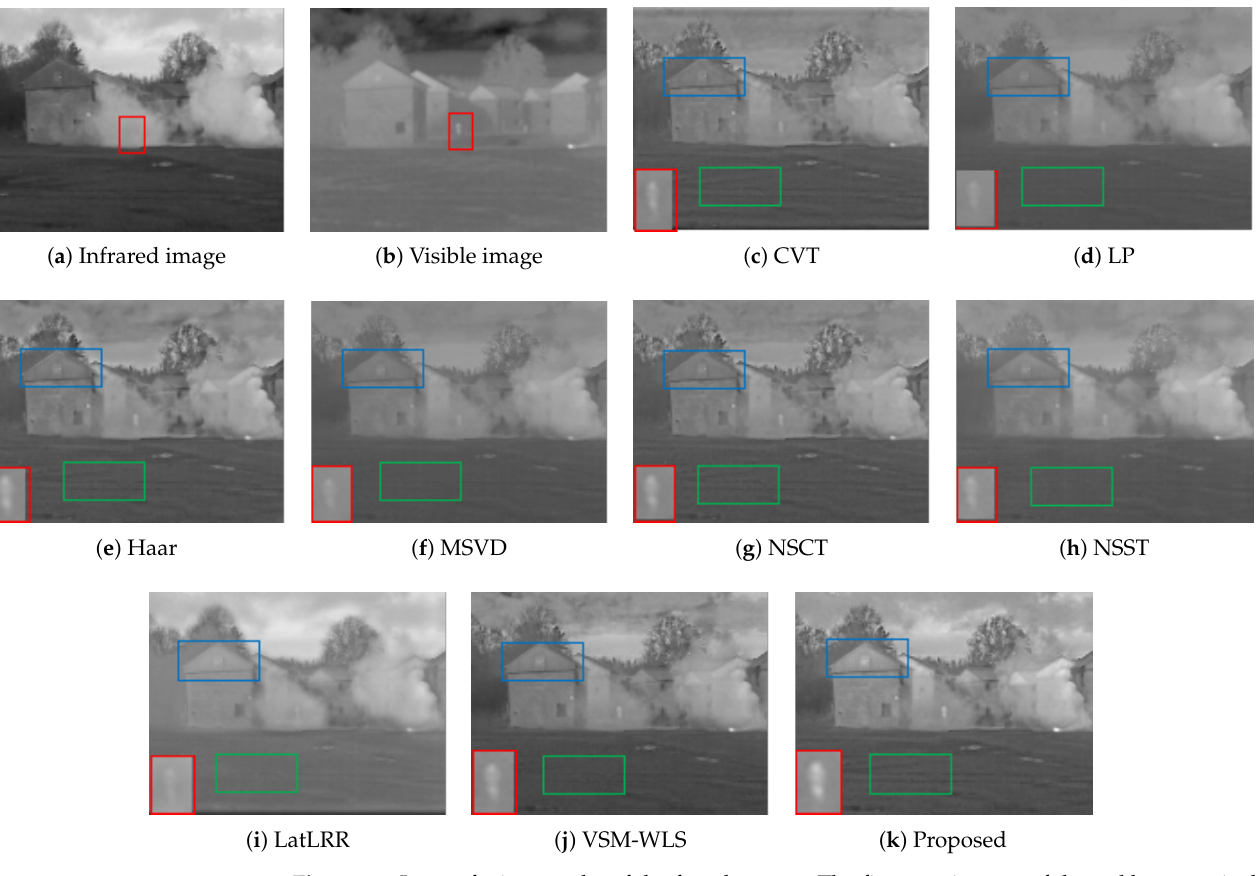
Figure 11. Image fusion results of the fourth group. The first two images of the red box part is the character position, the rest of the image red box part is the character amplification effect, green box and blue box part are significant contrast